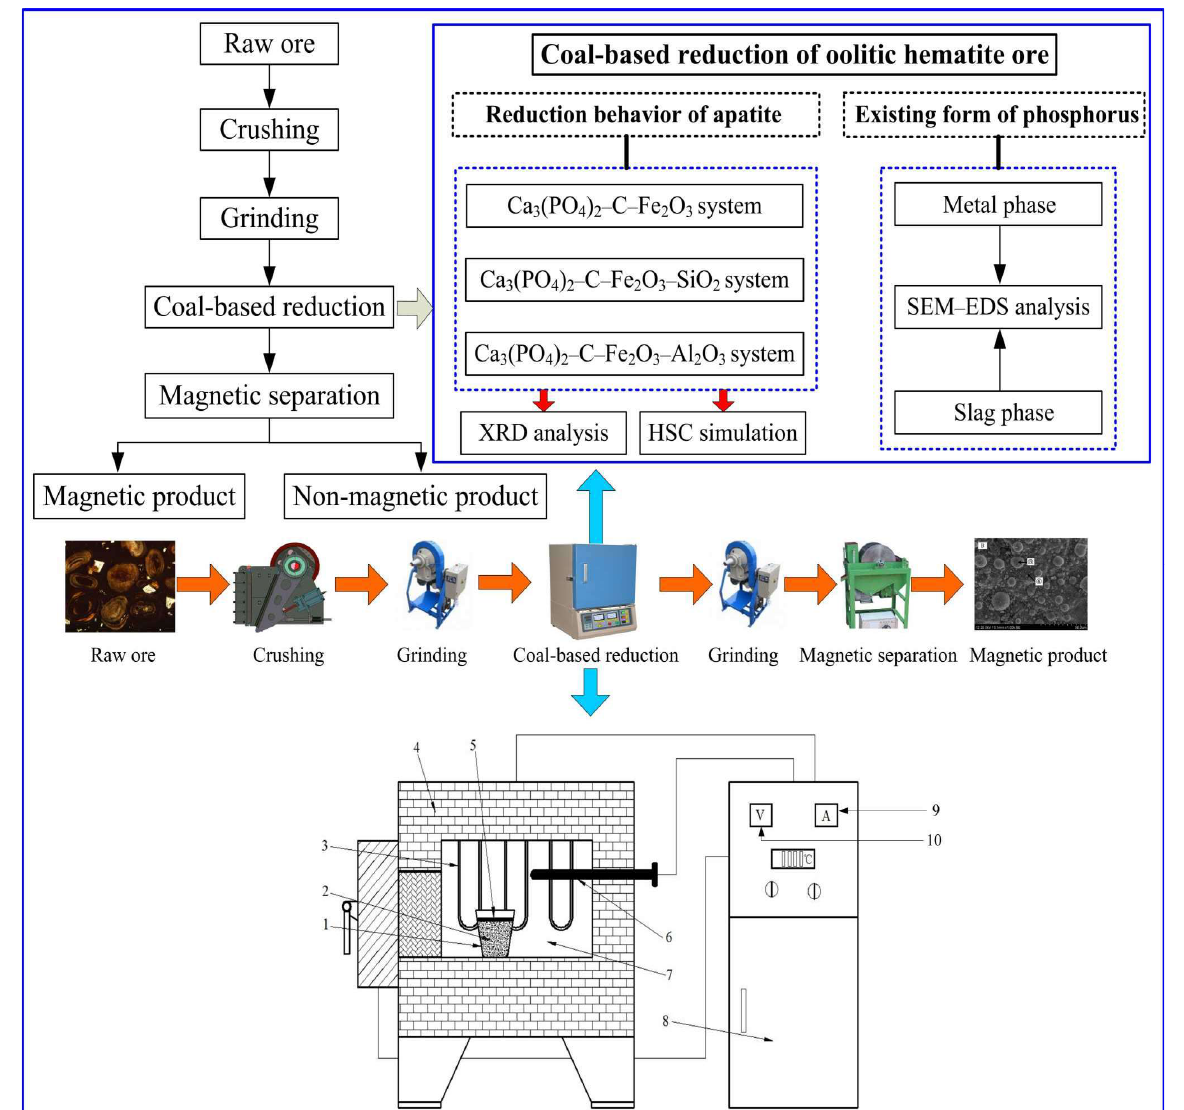
Figure 3. The schematic diagram of reduction behavior of apatite and existing form of phosphorus in coal-based reduction: 1-crucible; 2-reduction product; 3-heating rod; 4-furnace body; 5-protective coal; 6-thermocouple; 7-furnace; 8-control cabinet; 9-ammeter; 10-voltmeter.